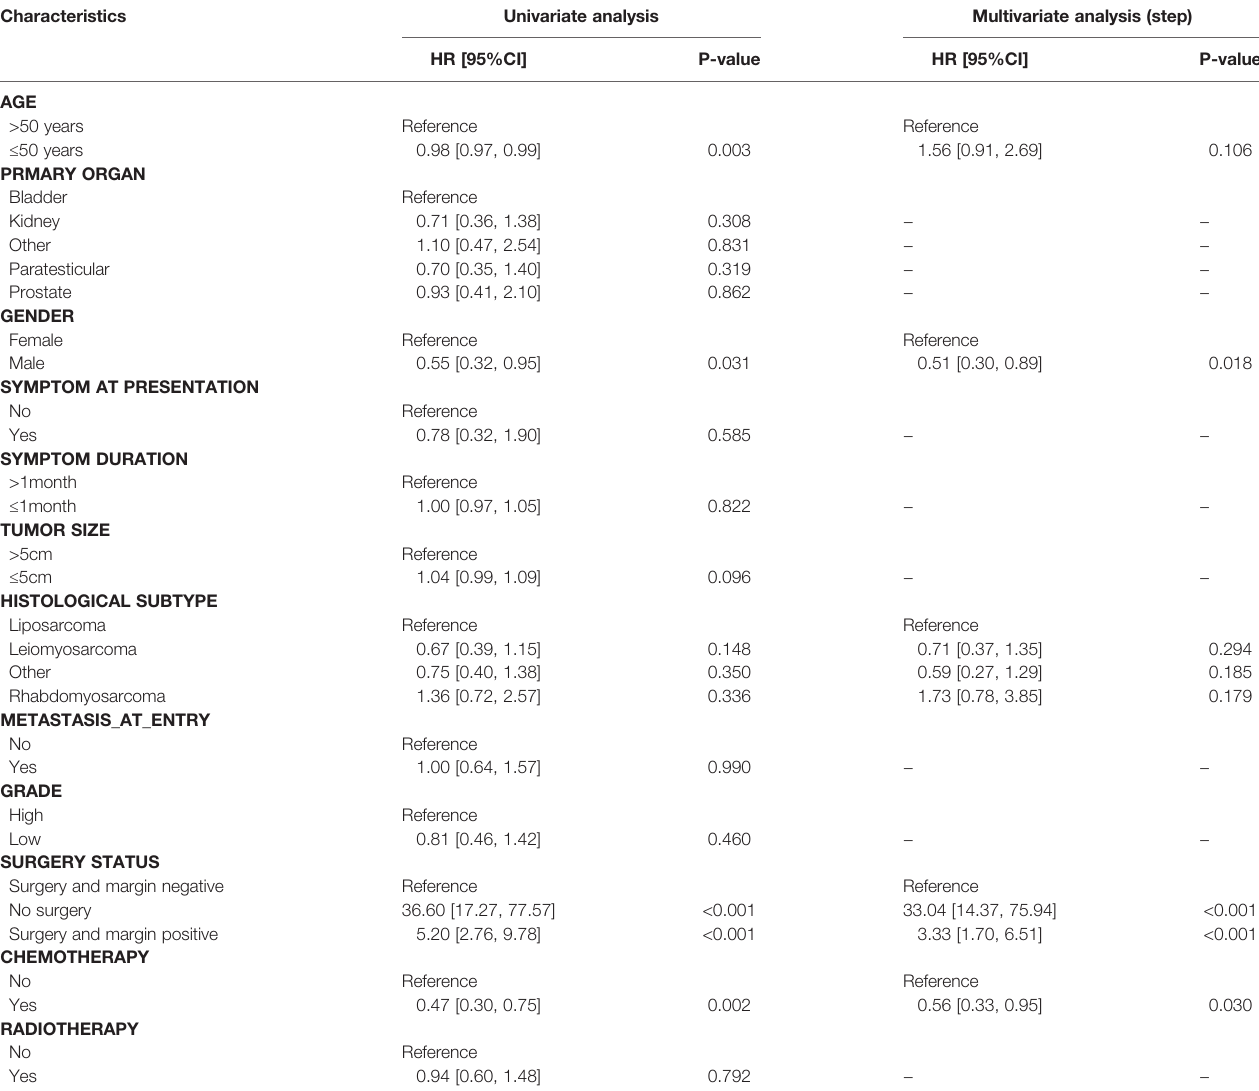
TABLE 5 | Univariate and multivariate analyses of overall survival in the training cohort.